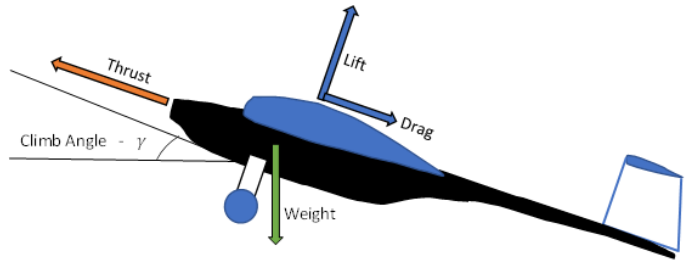
Figure 15. Forces applied in